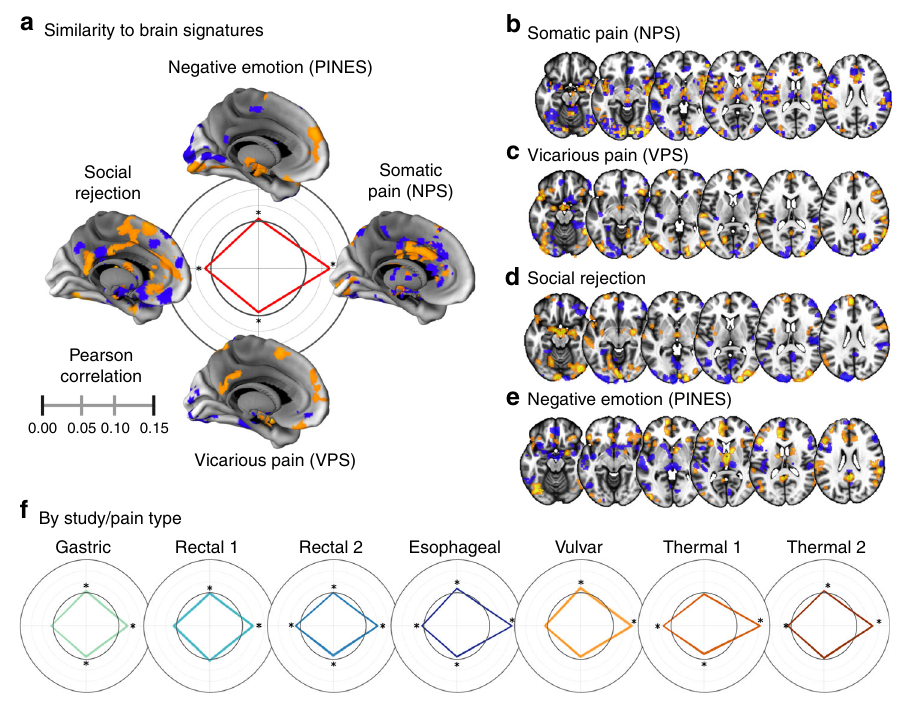
Fig. 2 Spatial similarity between responses to different pain types and neurologic signatures. a The similarity between brain responses pooled across pain types. Pearson correlations between pooled brain responses and neural signatures for somatic pain (NPS), vicarious pain (VPS), social rejection, and negative emotion (PINES). Lines show the mean association across participants, with shaded standard errors. The inner gray circle re fl ects a correlation of zero; points inside the circle are negative associations, and outside the circle are positive associations. Brain maps depict the 10,000 most positive and 10,000 most negative model weights on the cortical surface of the left hemisphere 29 and the basal ganglia 30 . These weights are shown for display purposes only to indicate the brain regions that have the greatest in fl uence in making predictions. Positive weights are shown in warm colors and negative weights in cool colors. * P < 0.05 (two-tailed, one-sample t test). b – e A visual depiction of the four neural signatures, with the same threshold as in ( a ). Warm colors indicate where increased activity leads to more positive outcomes and cool colors indicated where decreased activity leads to more positive outcomes. f Correlations between the average activity for each study. Scale and axes are identical to those in panel ( a ). * P < 0.05 (two-tailed, one-sample t test). Source data are provided as a Source Data fi le.